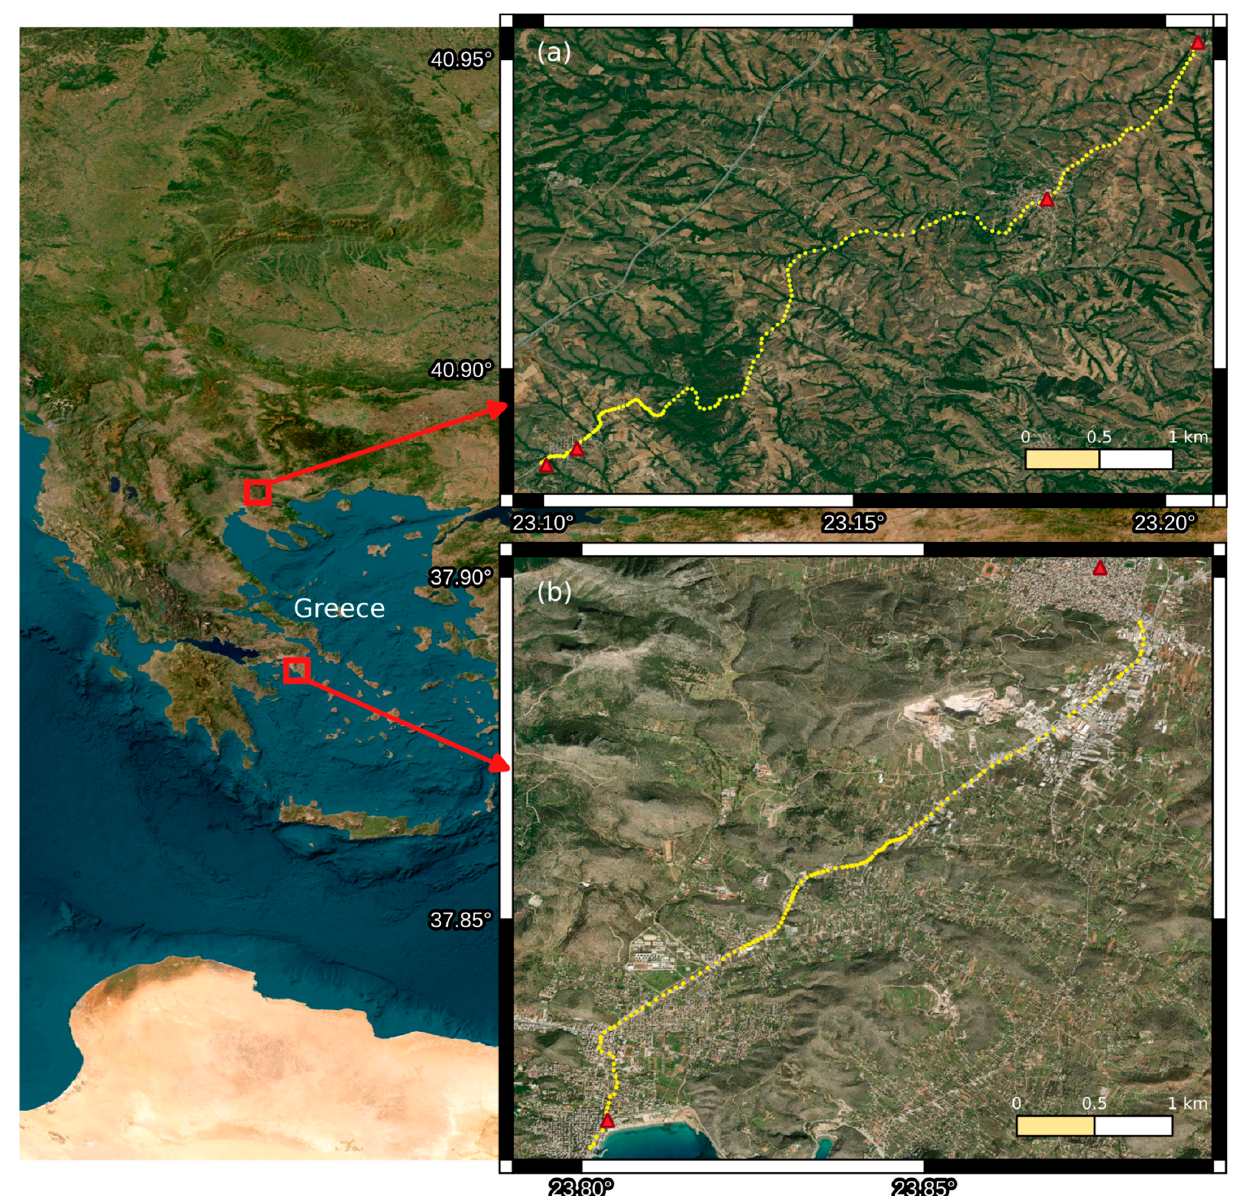
Figure 1. The study areas (red rectangles) in ( a ) Northern Greece and in ( b ) Central Greece. (Yellow circles: GNSS/leveling/gravity measurement points, red triangles: vertical network benchmarks). (Basemap: ESRI imagery).